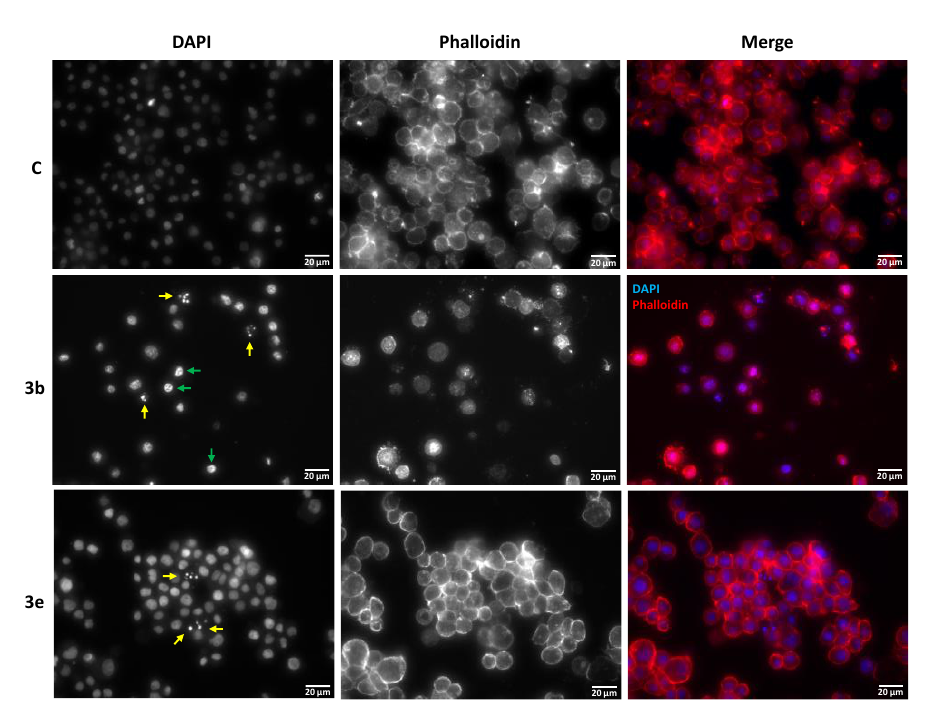
Figure 2. Morphology of Sf9 cells exposed to compounds 3b (100 µg/mL) and 3e (50 µg/mL) after 24 h of incubation (S Plan Fluor ELWD 40× DIC N1 objective). Overall cell morphology was evaluated using phalloidin (actin) and DAPI (chromatin status). Yellow arrow: chromatin fragmentation; green arrow: chromatin condensation; C: control. Color blind-friendly image in Supplementary Figure S1.